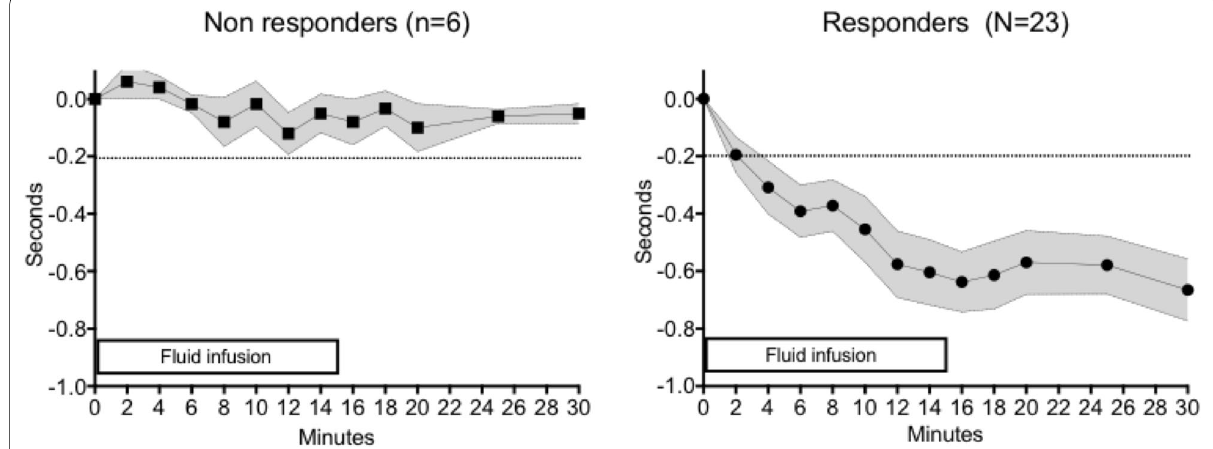
Fig. 2 Kinetics of the variations of fingertip CRT overtime in non‑responders (left) and in responders (right). Measurements started upon start of crystalloid infusion. Data were expressed as mean ±